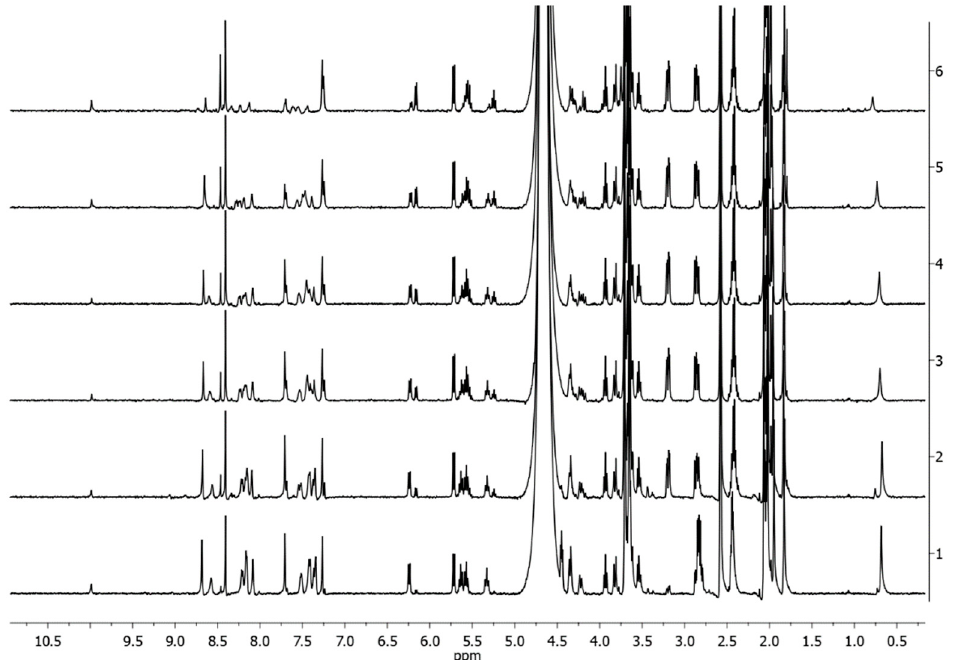
Figure 13. 1 H-NMR spectra of 2Pt-im incubated with GSH in 9:1 v/v PB:DMSO- d 6 (1 mM of Pt, 2.5 eq of GSH) at 37 ◦ C at different times (1 = start, 2 = 2 h, 3 = 4 h, 4 = 6 h, 5 = 24 h, 6 = 48 h). Such resonances can be attributed to the release of the imidazole ligand and the consequent formation of unidentified species. Such peaks decrease in intensity over time until they almost disappear (in the case of 4Pt-py , completely; Figure S22), probably because of